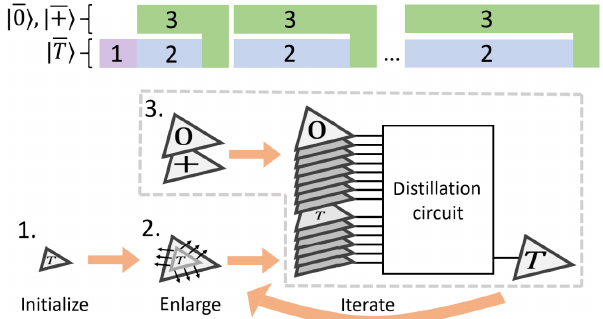
FIG. 20. Protocol to create an encoded T state via state distil- lation, with a qualitative timeline of each step. In step 1, noisy encoded T states are prepared non-fault-tolerantly in a small 2D color code. In step 2, each code patch is expanded to increase its distance, and we assume that the logical infidelity of the encoded T state does not change. In step 3, 16 logical states, either | 0 (cid:2) or |+(cid:2) , are prepared and then the state-distillation circuit is run on them and 15 | T (cid:2) ’s. Given successful postselection, the output is a single encoded T state of higher fidelity (indicated by a larger font size). Steps 2 and 3 are iterated until a state of the desired infidelity is